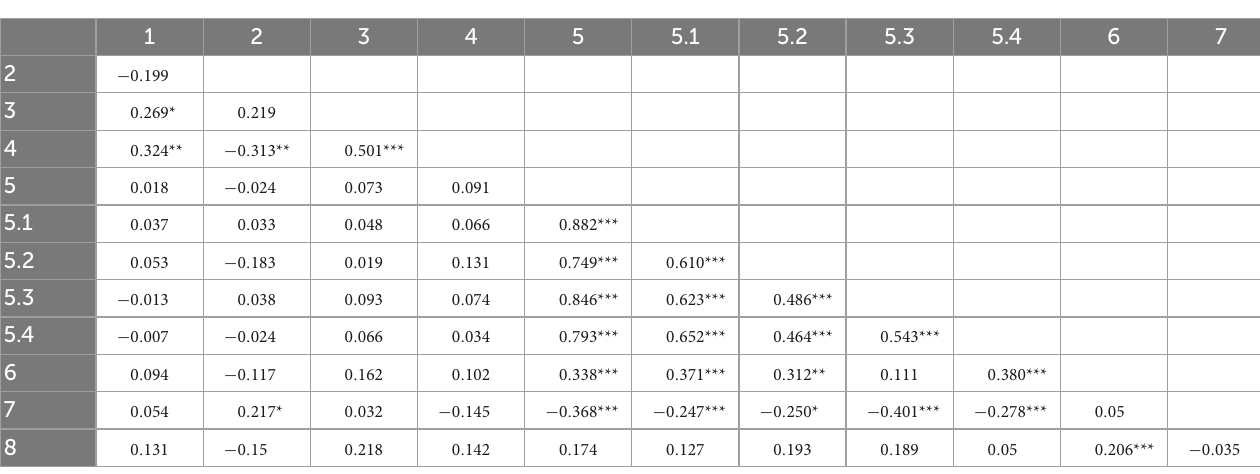
TABLE 2 Correlation results of leadership